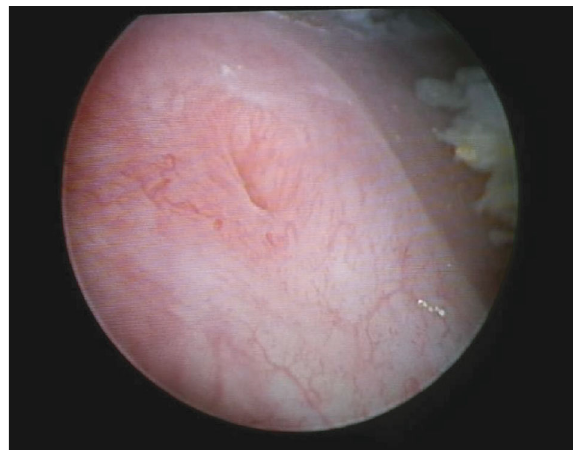
Figure 2: Right ori fi ce was completely spared by plaques.